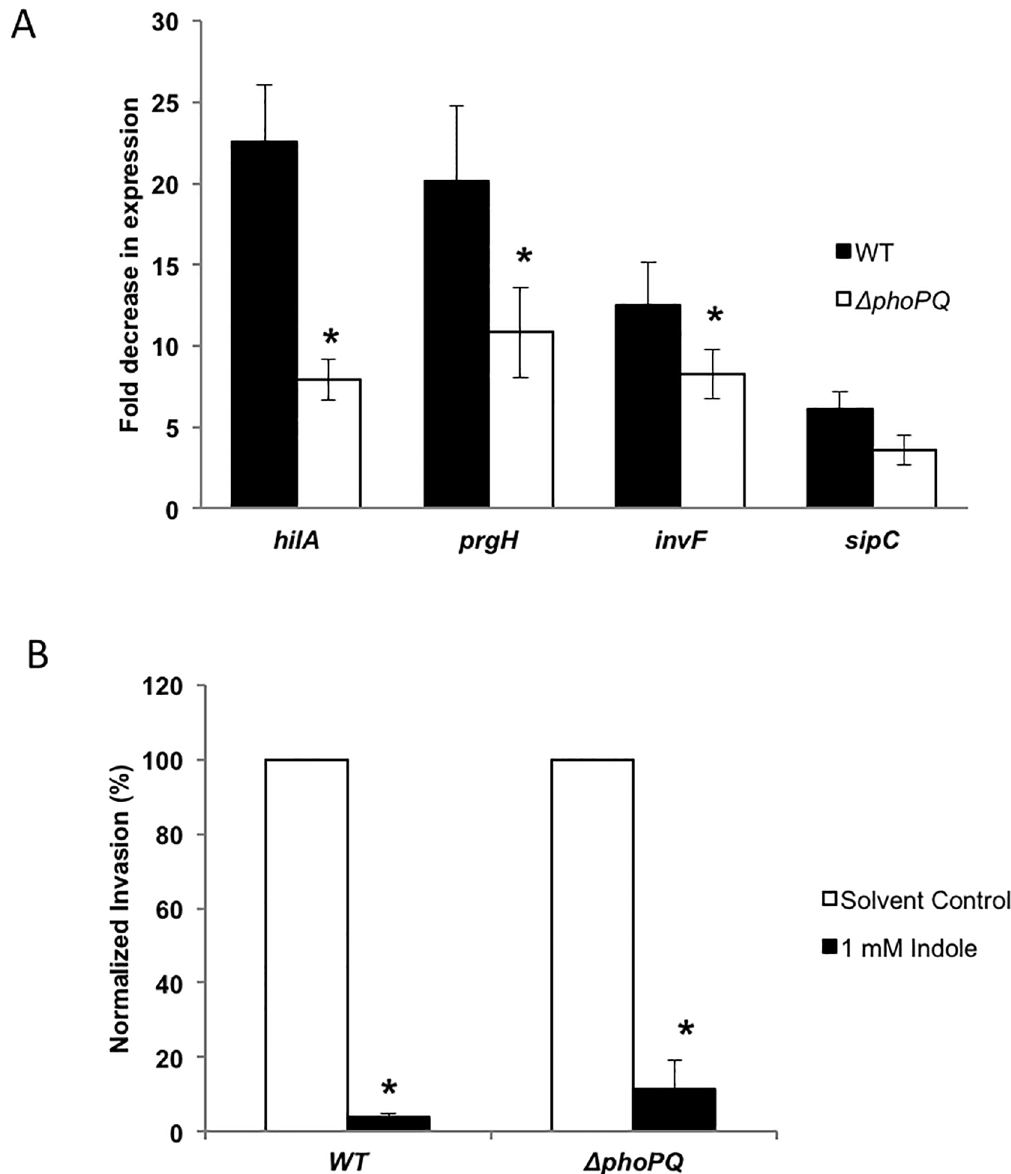
Fig 5. Role of phoPQ in indole mediated down-regulation of virulence. (A) SPI-1 virulence gene expression using ß-gal assay. The Δ phoPQ mutation was generated in the four SPI-1 reporter strains for hilA , prgH , invF and sipC . The WT and the Δ phoPQ reporter strains were treated overnight with and without 1 mM indole and the ß-gal activity was measured in exponential phase cultures after dilution. Data shown are the fold decrease in expression with indole-treatment relative to the solvent-treated control. (cid:3) denotes statistical significance relative to the WT strain at p < 0.05 using the Student’s t -test. (B) Invasion in HeLa epithelial cell line with Salmonella WT and Δ phoPQ strain treated with or without 1mM indole. A MOI of 100:1 was used and the data shown is the indole-treated Salmonella invasion normalized to the control of the respective strain. (cid:3) denotes statistical significance with respect to the solvent control at p < 0.05 using the Student’s t -test. Column bars depict mean (n = 3) and error bars represent standard deviation